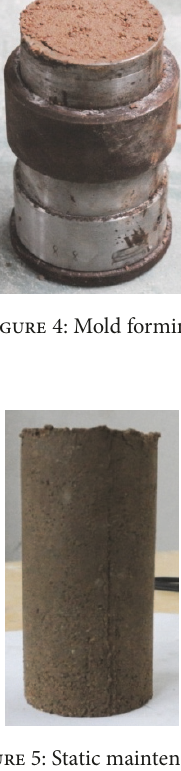
Figure 5: Static maintenance.